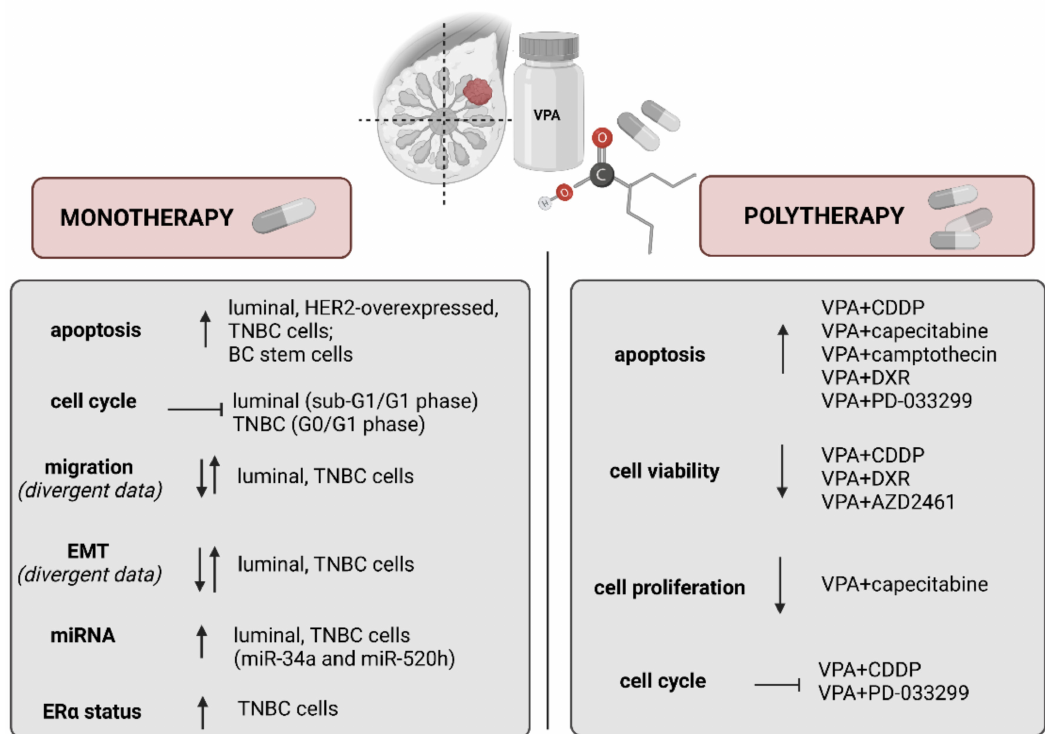
Figure 4. The functional mechanism of valproic acid in breast cancer treatment (BC-breast cancer, CDDP-cisplatin, DXR- doxorubicin, ER-estrogen receptor, EMT-epithelial-mesenchymal transition, HER2-human epidermal growth factor receptor 2, TNBC-triple-negative breast cancer, VPA-valproic acid) ( ↑ —increase, ↓ —decrease,